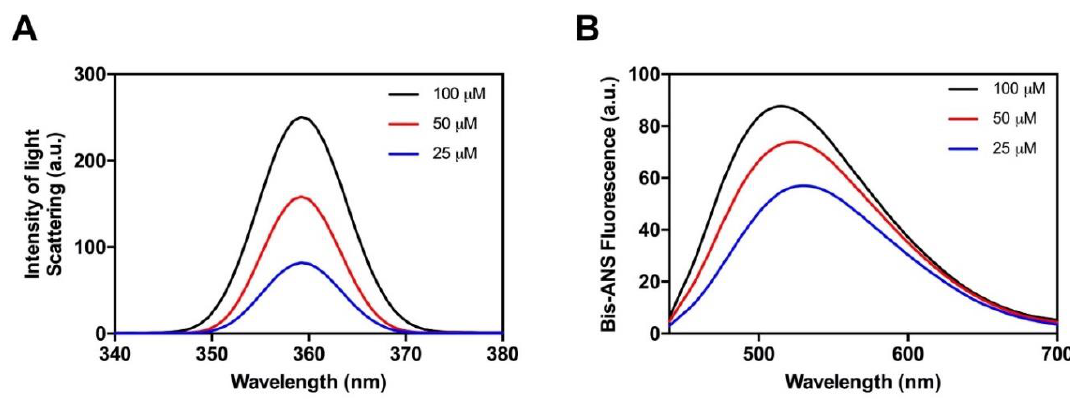
Figure 2. Aggregation of the soft amyloid core in Hsf1 as a function of the concentration. Aggregation ( A ) and the formation of hydrophobic surfaces ( B ) were monitored by light scattering and 4,4-bis-1-anilinonaphthalene-8-sufonate (Bis-ANS) fluorescence emission, respectively, at various peptide concentrations.